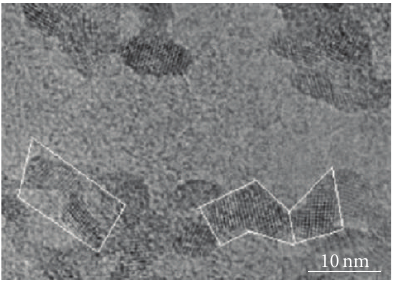
Figure 11: HRTEM image of 0.5 at % Fe(III)-doped TiO 2 nanopar- ticles.